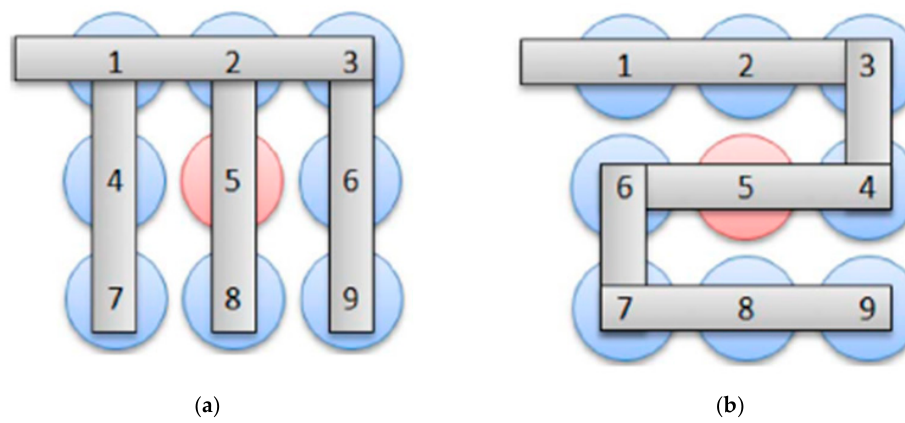
Figure 7. Two typical tab configurations of packs: ( a ) branched style of tabbing (M-type); ( b ) serpentine style of tabbing (S-type). Adopted from Ref. [126].